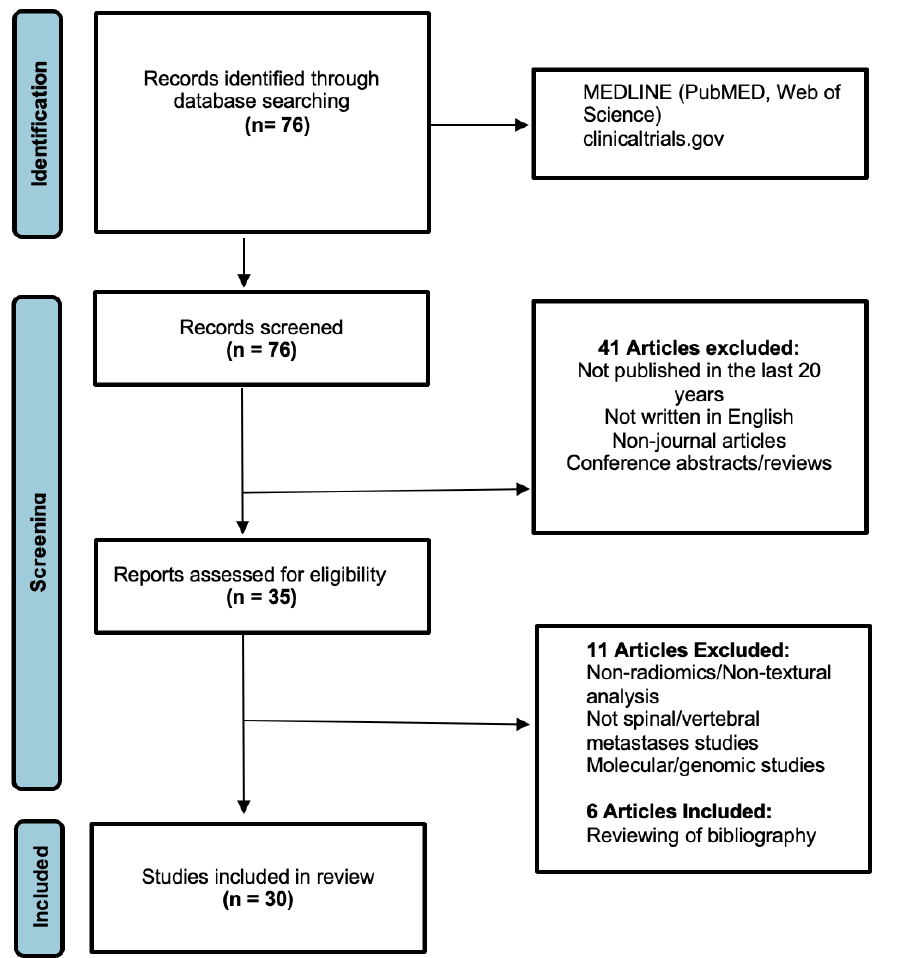
Figure 1. PRISMA flowchart for the literature search (this is adapted from the PRISMA group, 2020), which describes the selection of relevant articles.